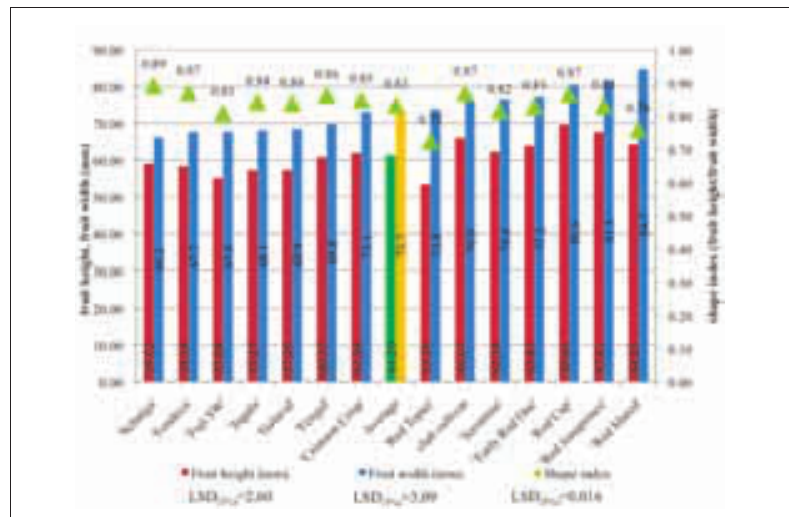
Figure 5: Fruit size and shape-index of the apple cultivars (Nyírbátor,